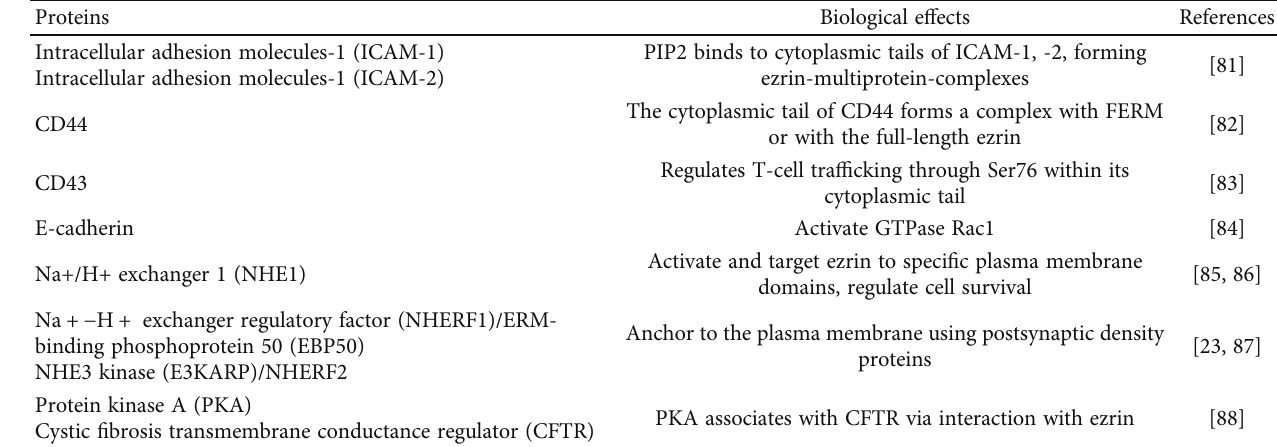
Table 2: Regulation of ezrin by other proteins.